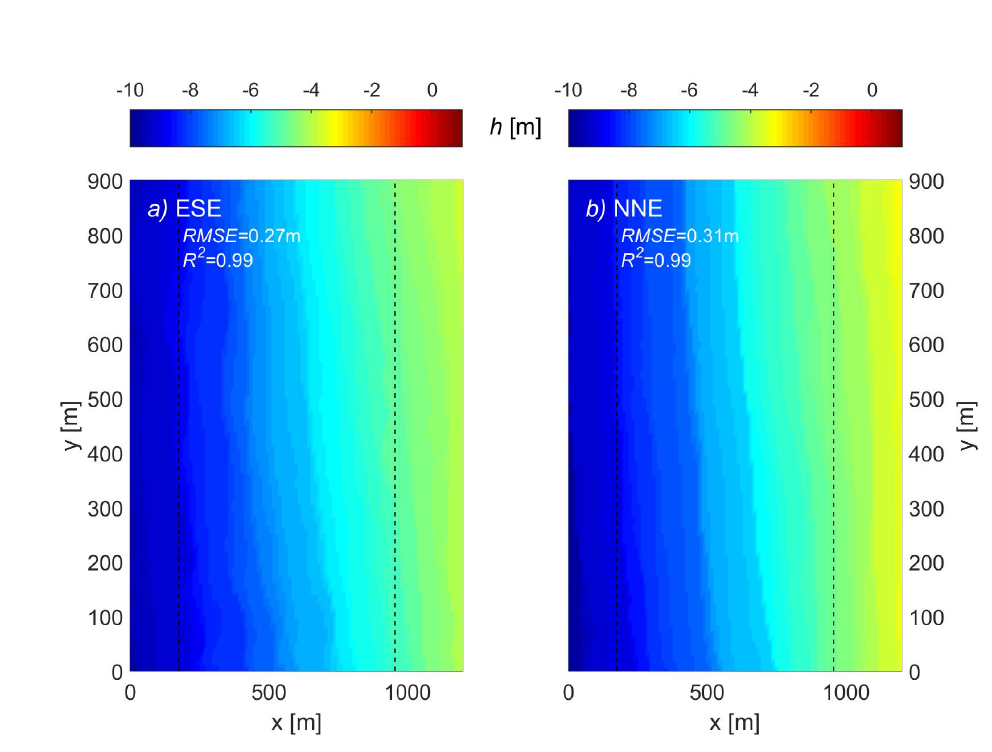
Figure 5. Reconstructed bathymetries: ( a ) ESE and ( b ) NNE simulations. Dashed lines indicate the locations at which the boundary conditions are